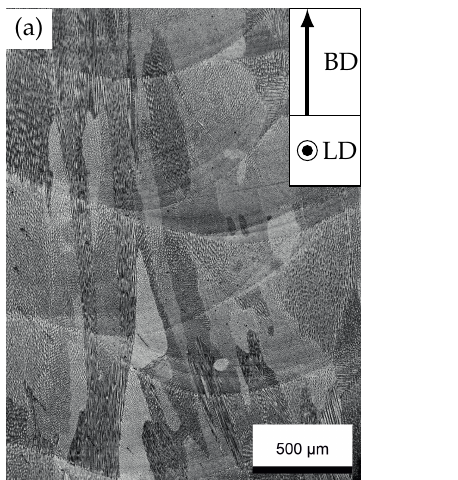
Figure 4. Etched micrographs detailing ( a ) AISI316L and ( b ) CoCrMo microstructure in as-built condition, obtained by laser-based DED. BD is